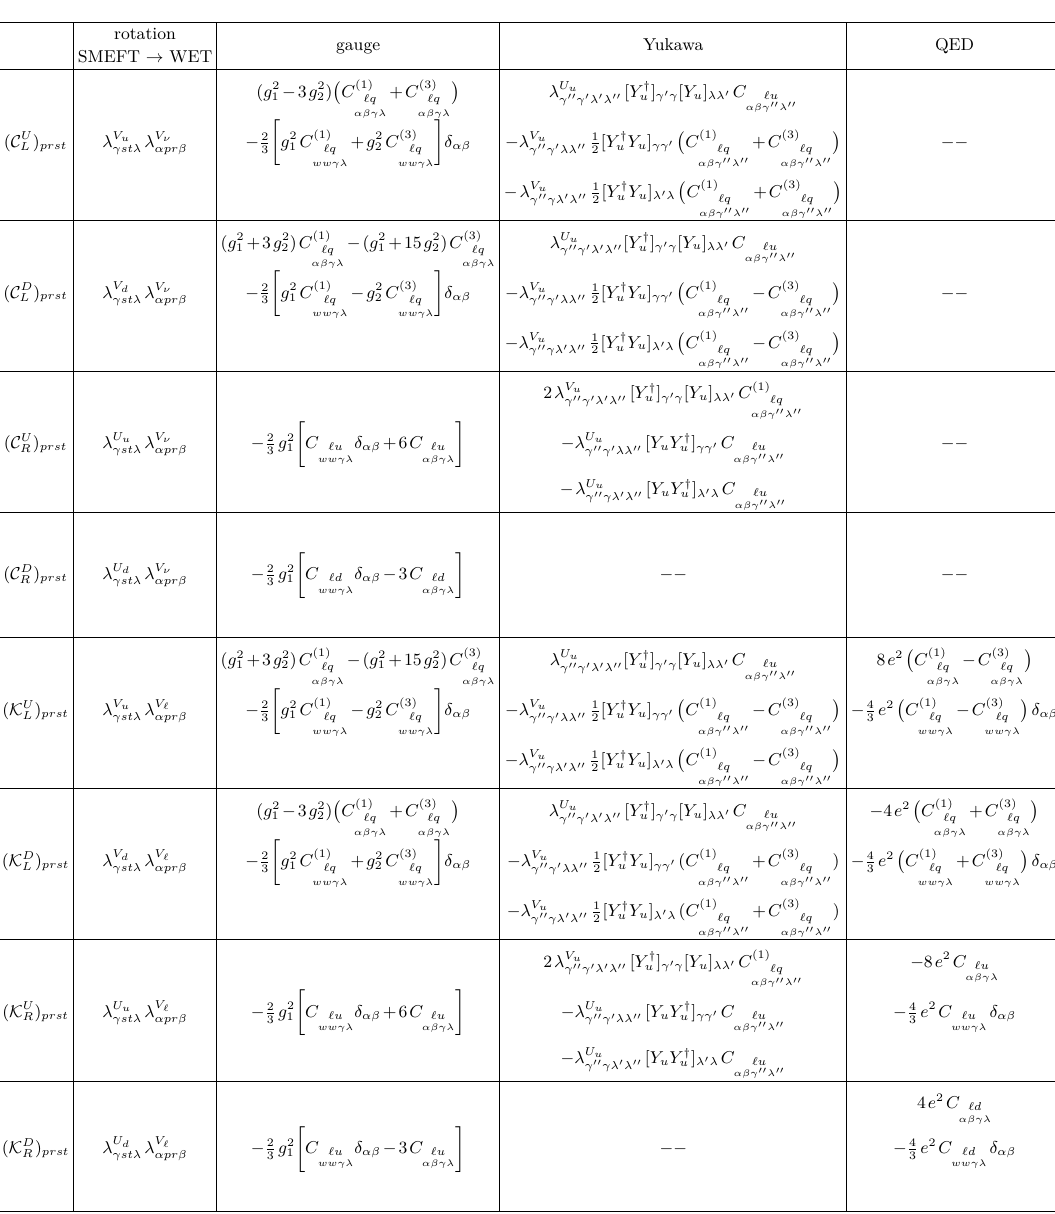
as eq. (A.4) separated by RGE corrections from gauge [63], Yukawa [64], Table 6 . Coefficients ξ C i and QED [65] coupling